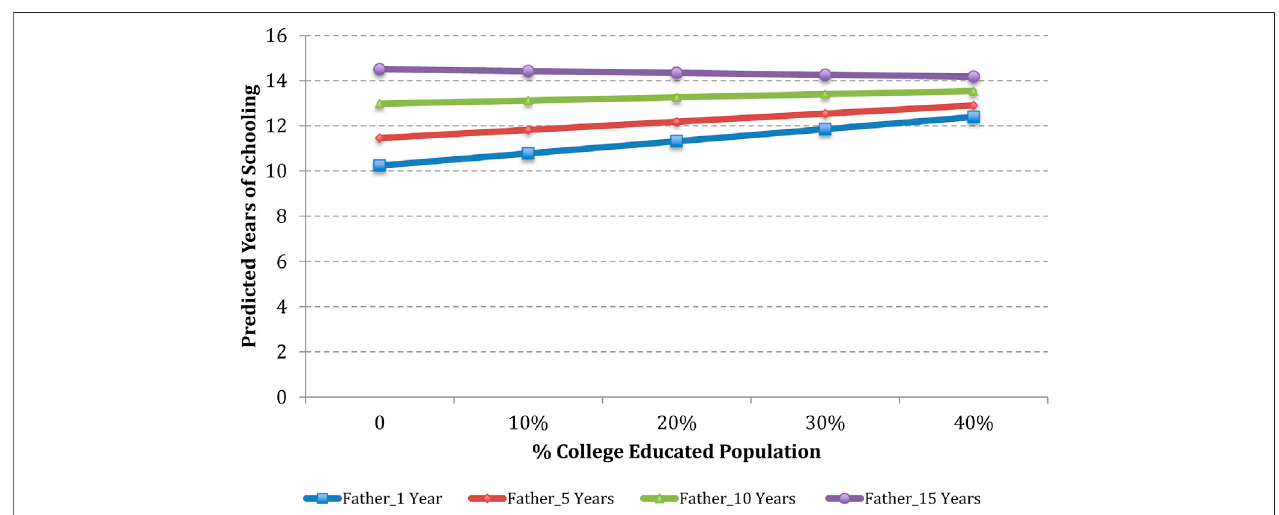
FIGURE 2 | Predicted years of schooling of 2nd generation Hispanic men as a function of the level of father ’ s schooling and percentage of the college-educated population in the county.